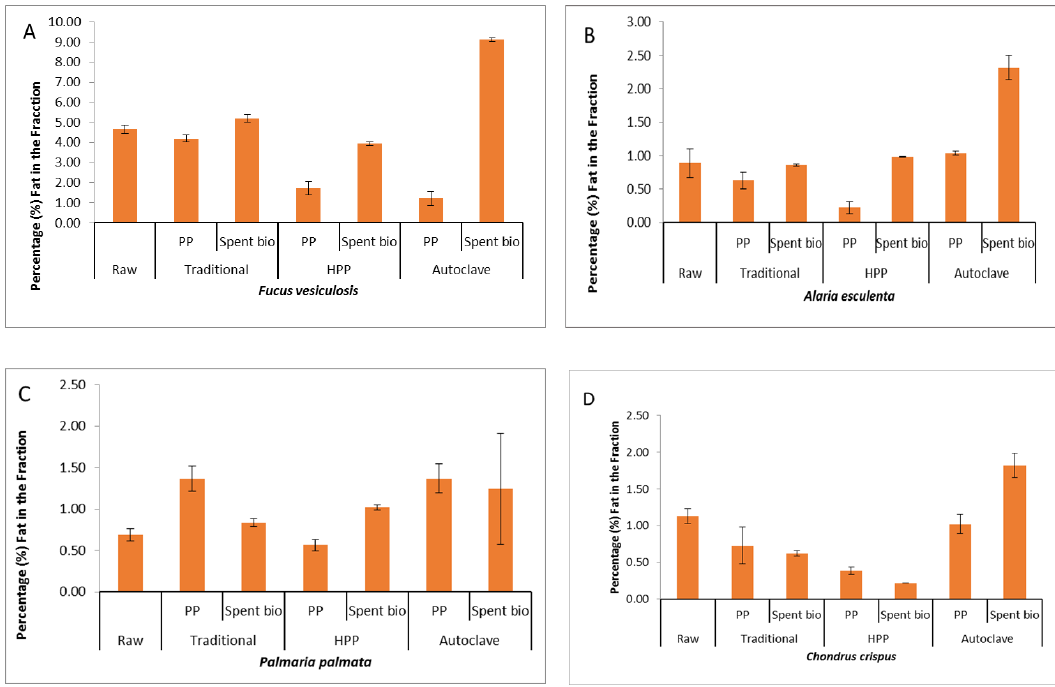
Figure 1. A – D : Percentage (%) lipid in raw, protein pellets and spent biomass of macroalgae.